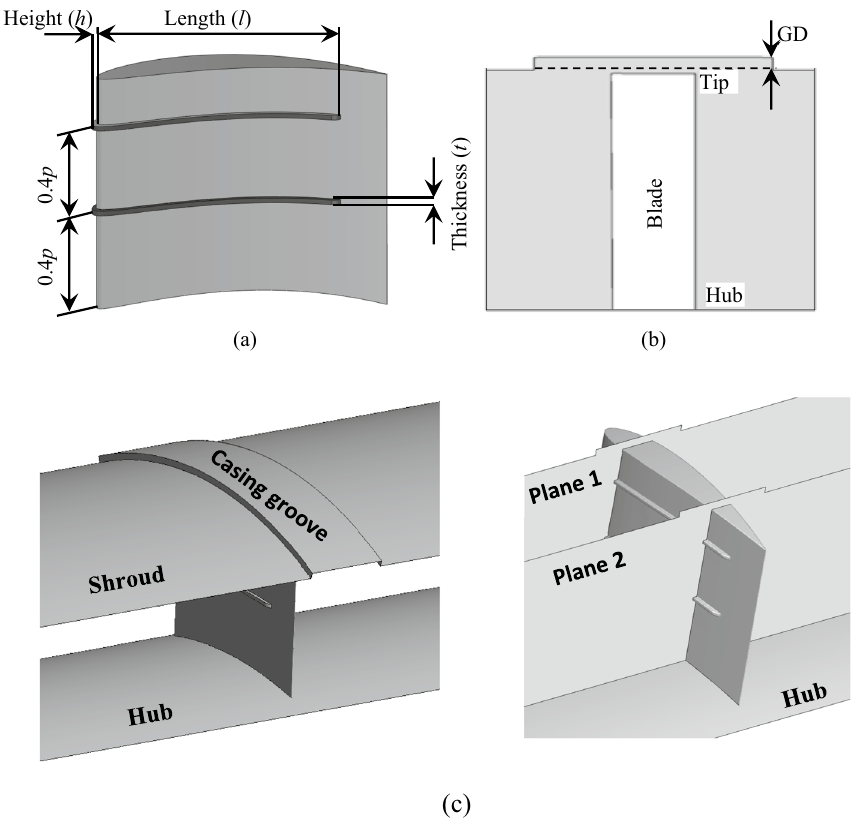
Figure 3. Geometric configurations of the blade with stall fences and casing groove ( a ) details of SFs and ( b ) details of CG ( c ) details of the combined stall fence and casing